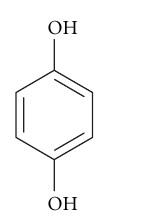
Figure 1: Chemical structure of